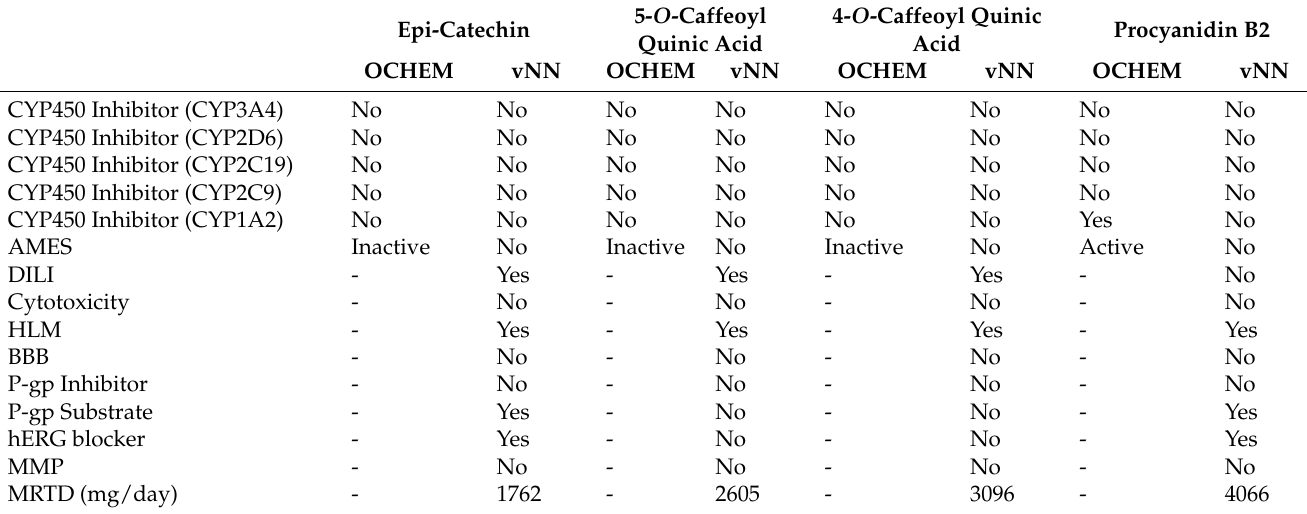
Table 5. ADMET prediction using OCHEM and vNN-ADMET web